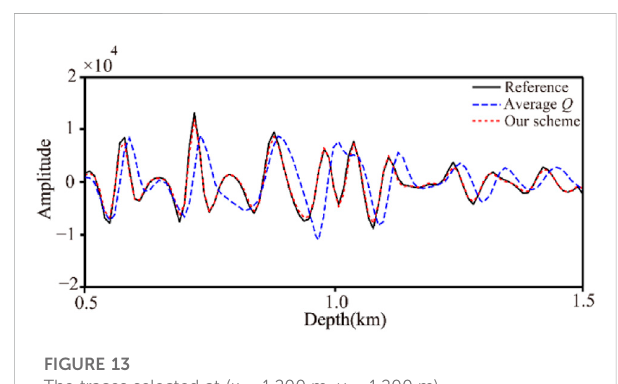
FIGURE 13 The traces selected at ( x = 1,200 m, y = 1,200